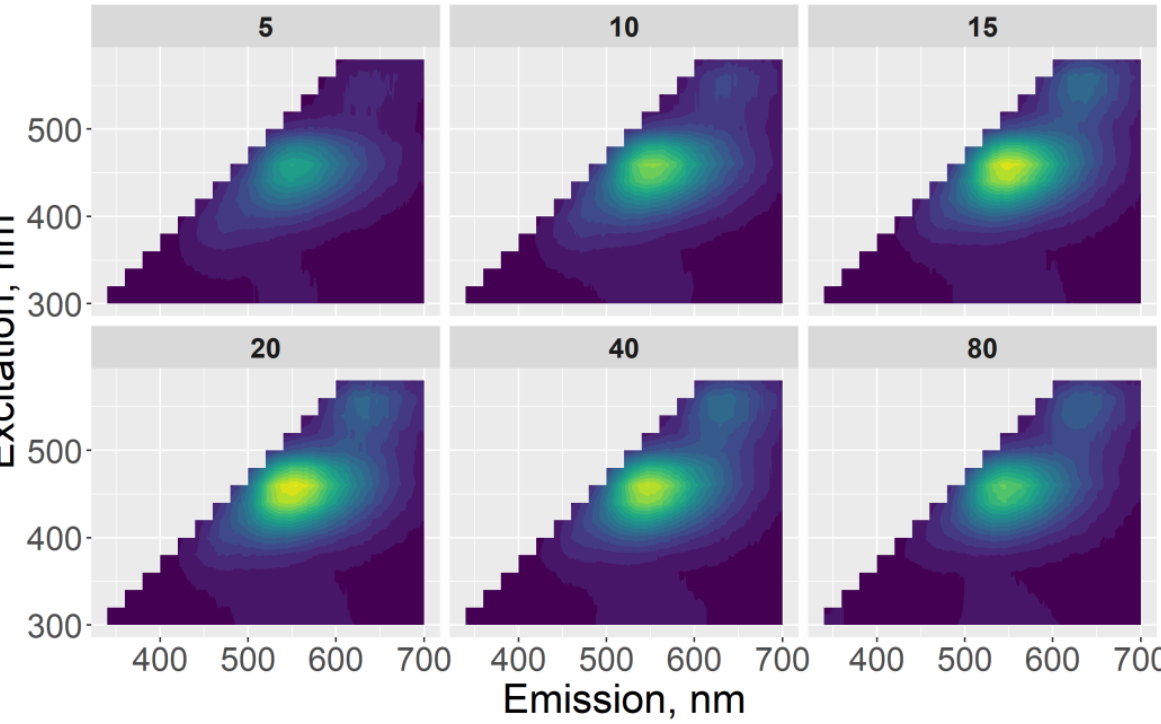
Figure 7. Maps of emission spectra of a purified sample at different excitation wavelengths. Sample composition: urea/citric acid 1:1. Dilution factor is shown in the subplot captions.